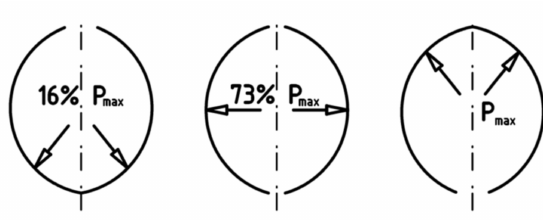
Figure 1. Unit pressure value distribution during the briquetting process in a roller press. P max , maximum unit pressure